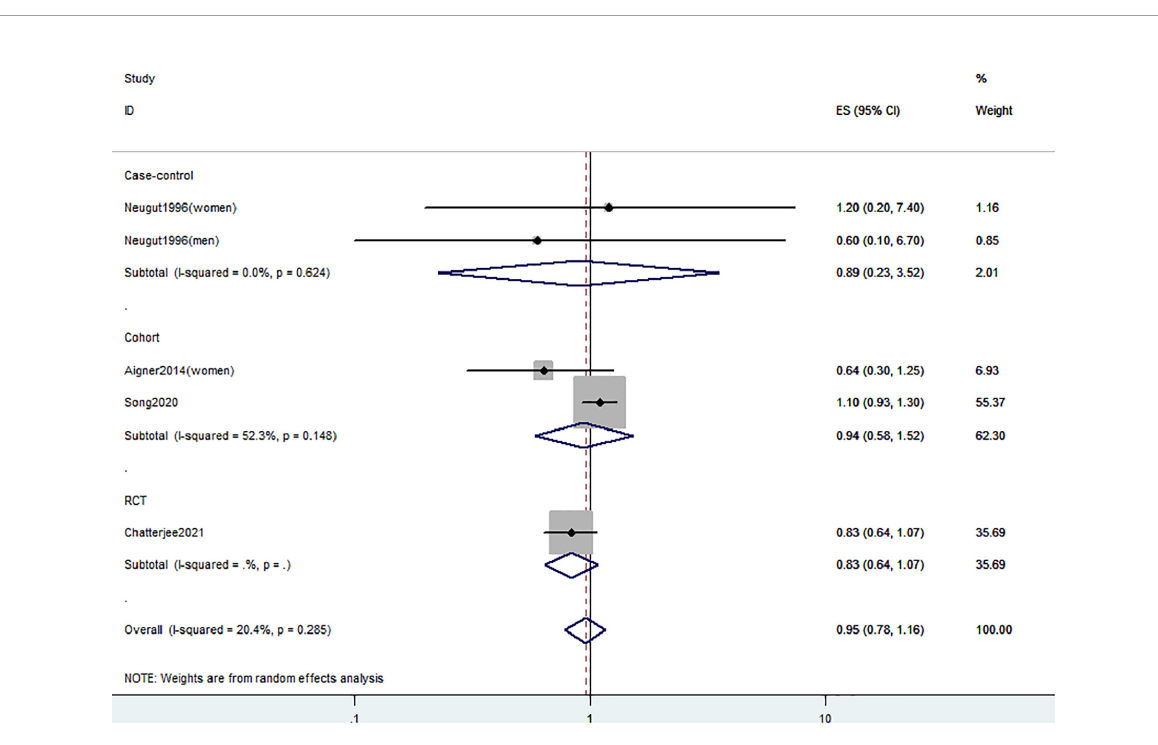
FIGURE4 Random-effects meta-analysis of studies that examined supplementary vitamin D intake and risk of CRC precursors incidence. ES, effect